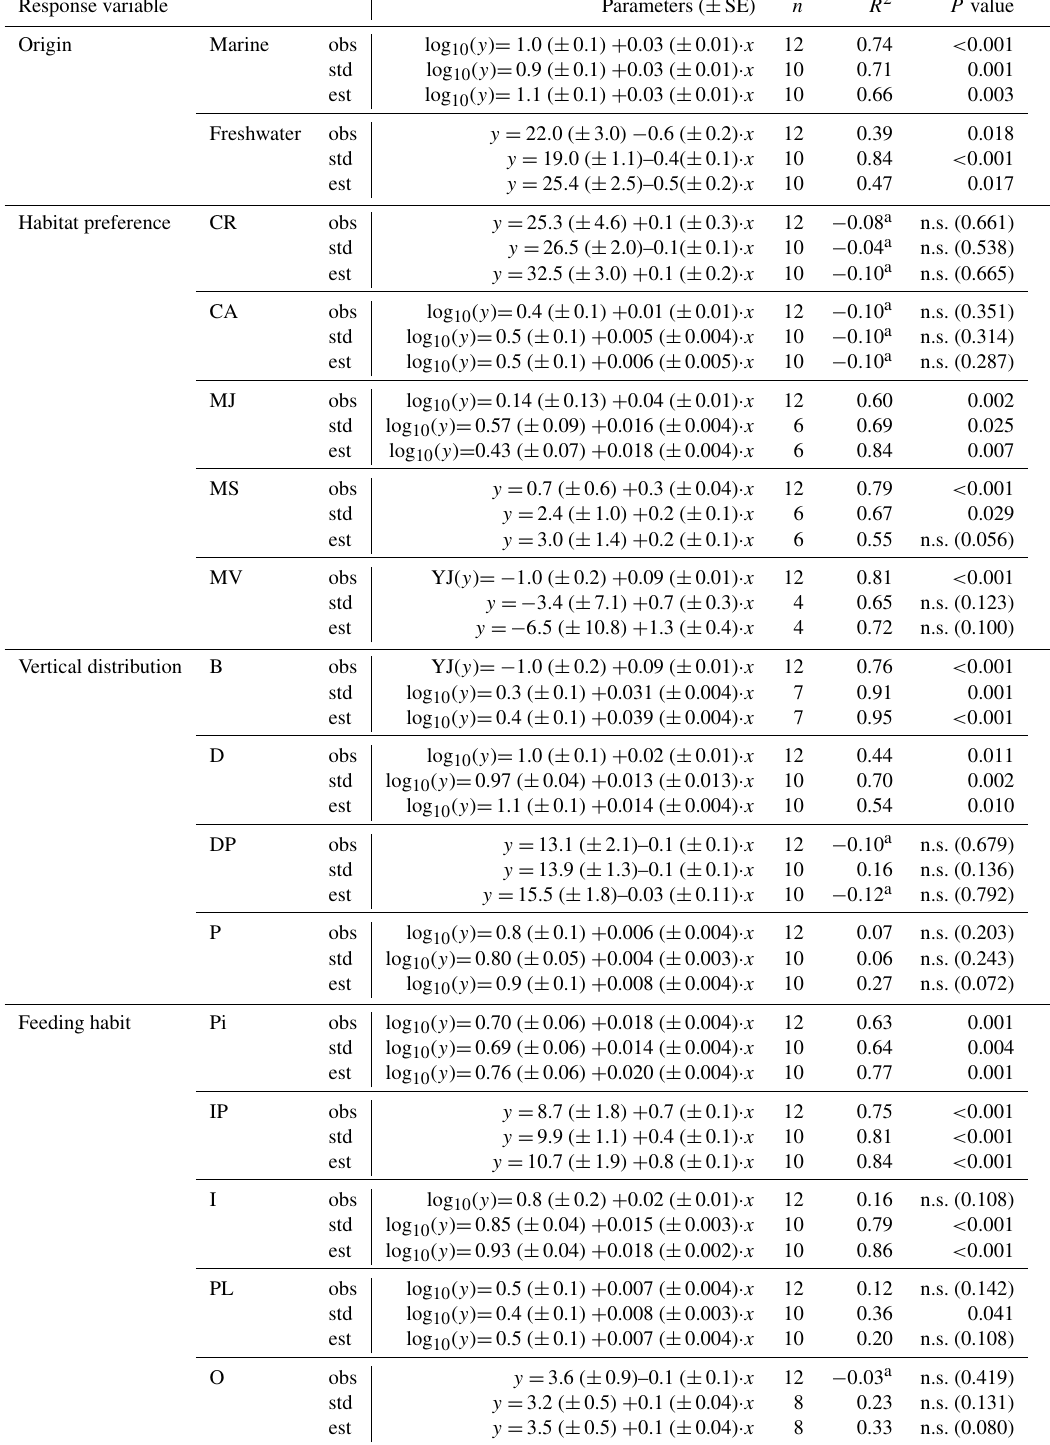
Table 3. Simple linear regressions between salinity and SR for the different fish functional attributes (observed (obs), standardized (std) and estimated (est) SR) in Swedish shallow coastal areas. YJ( y ) denotes that the response variable was Yeo–Johnson transformed (Yeo and Johnson, 2000). n.s. = not